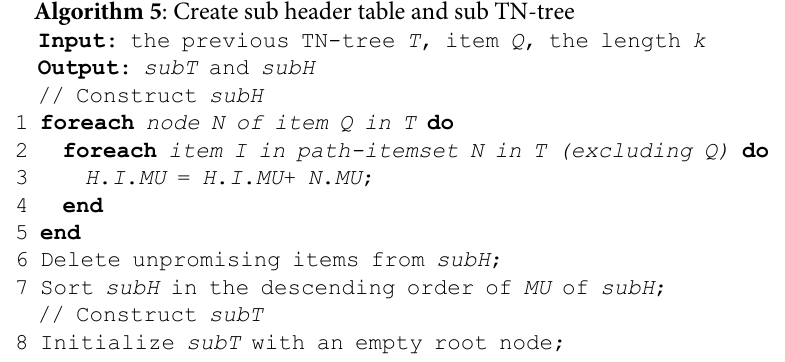
Algorithm 5 : Create sub header table and sub TN-tree